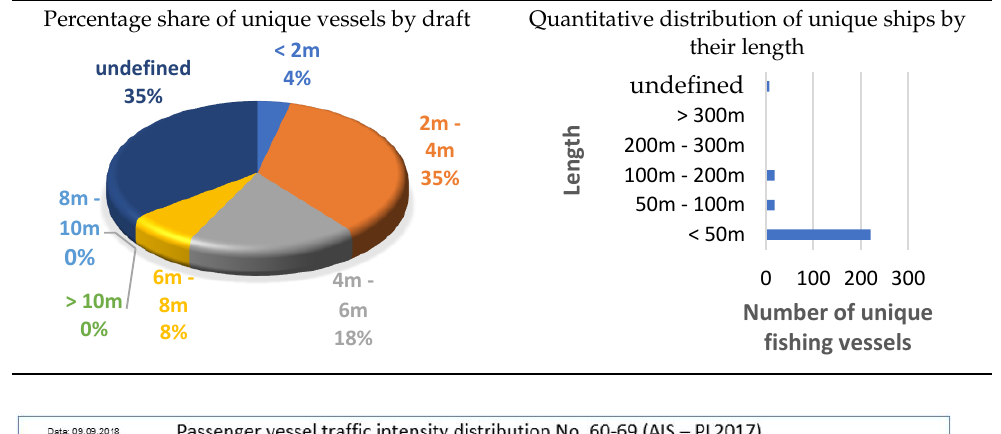
Table 3. Qualitative characteristics of fishing vessels.